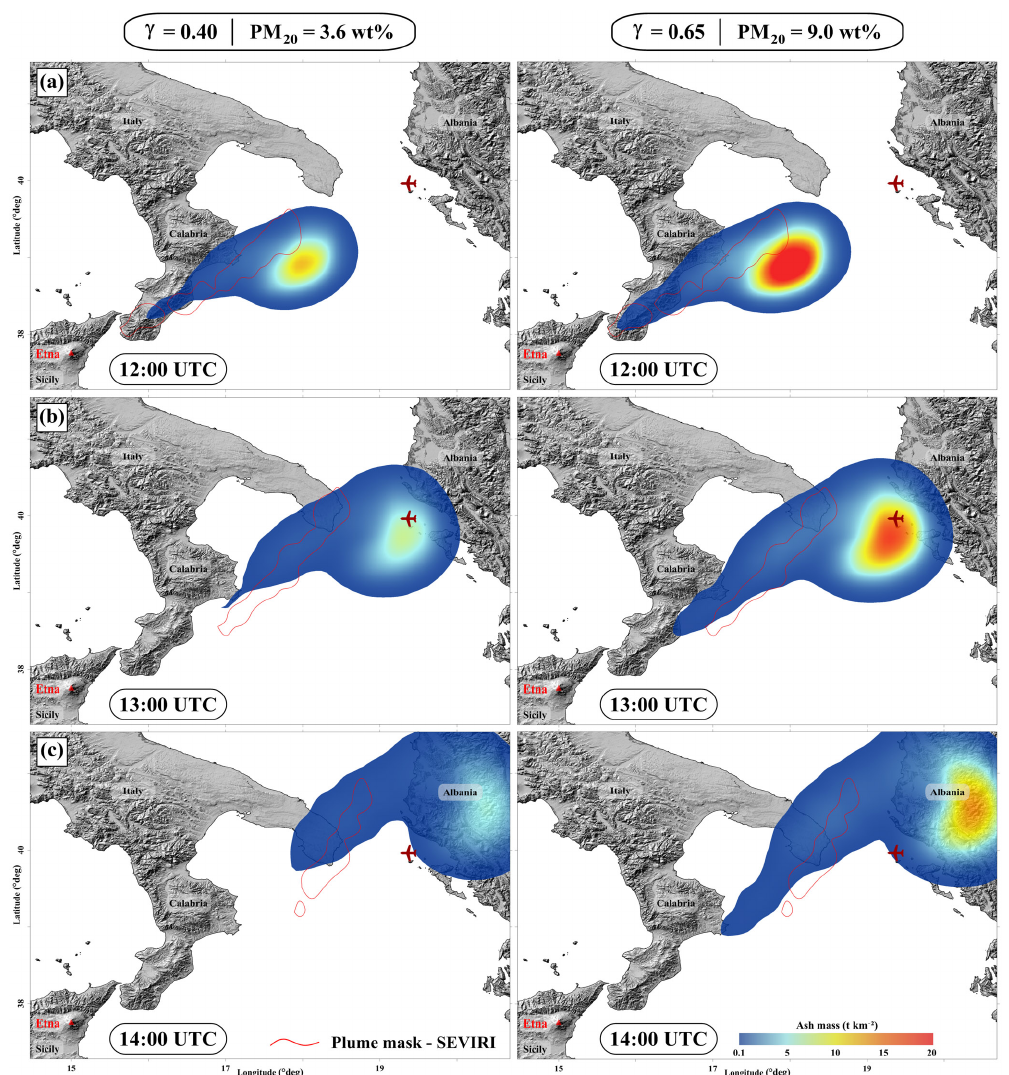
Figure 11. Illustration of the comparative study between the SEVIRI and FALL3D airborne ash masses for a given time (i.e. 12:00, 13:00 and 14:00) to best reproduce the satellite